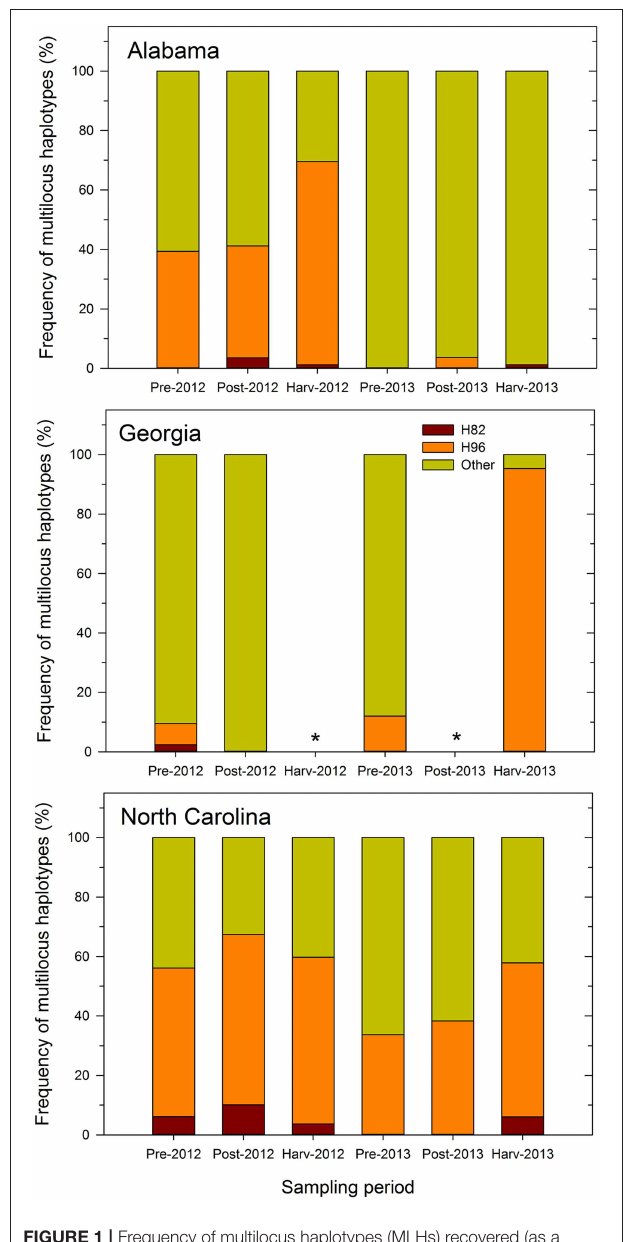
FIGURE 1 | Frequency of multilocus haplotypes (MLHs) recovered (as a proportion of the total number of MLHs observed) at each sampling period from maize fields in Alabama, Georgia, and North Carolina in 2012 and 2013 using combined MLST loci ( trpC , AF17, and mfs ) sequence data. Pre- and post-denotes sampling time before and after application of Afla-Guard and AF36. MLHs are designated as belonging to either the Afla-Guard MLH (H96), AF36 MLH (H82), or neither of these two MHLs (Other). The asterisk (*) indicates that soil samples were not collected at harvest in 2012 and at post-application of the biocontrol in 2013 in Georgia and there is no corresponding MLH frequency